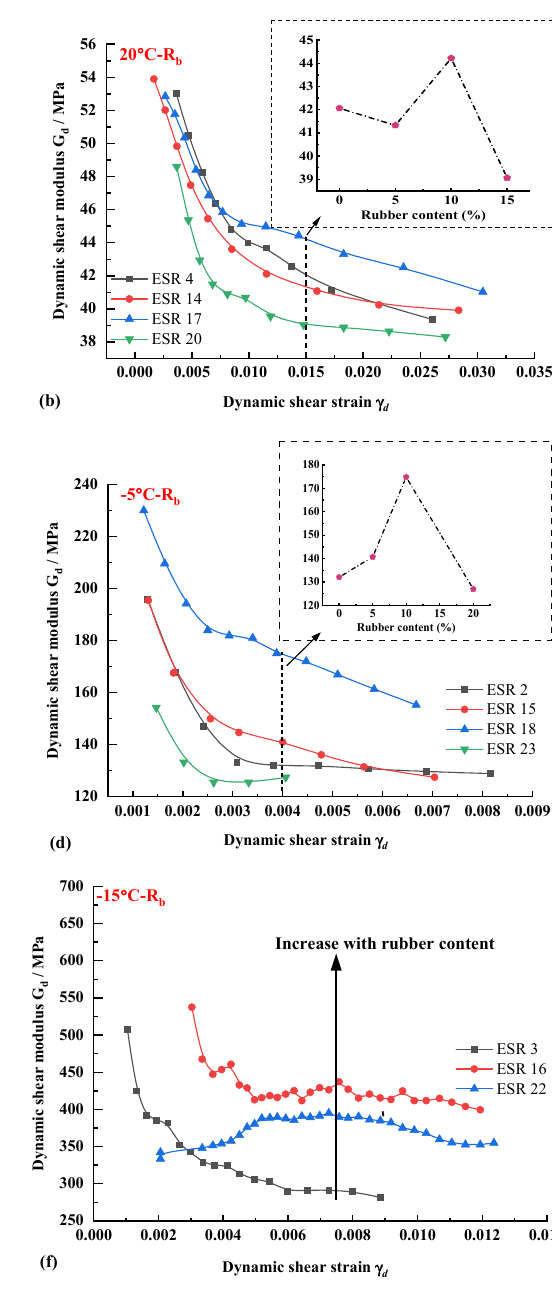
Figure 9. Dynamic shear modulus of expansive soil under different rubber forms and yields. ( a ) 20 °C R a specimens. ( b ) 20 °C R b specimens. ( c ) − 5 °C R a specimens. ( d ) − 5 °C R b specimens. ( e ) R a specimens. ( b ) 20 ◦ C R b specimens. ( c ) − 5 ◦ C R a specimens. ( d ) − 5 ◦ C R b specimens. ( e ) − 15 ◦ C − 15 °C R a specimens. ( f ) − 15 °C R b specimens. R a specimens. ( f ) − 15 ◦ C R b